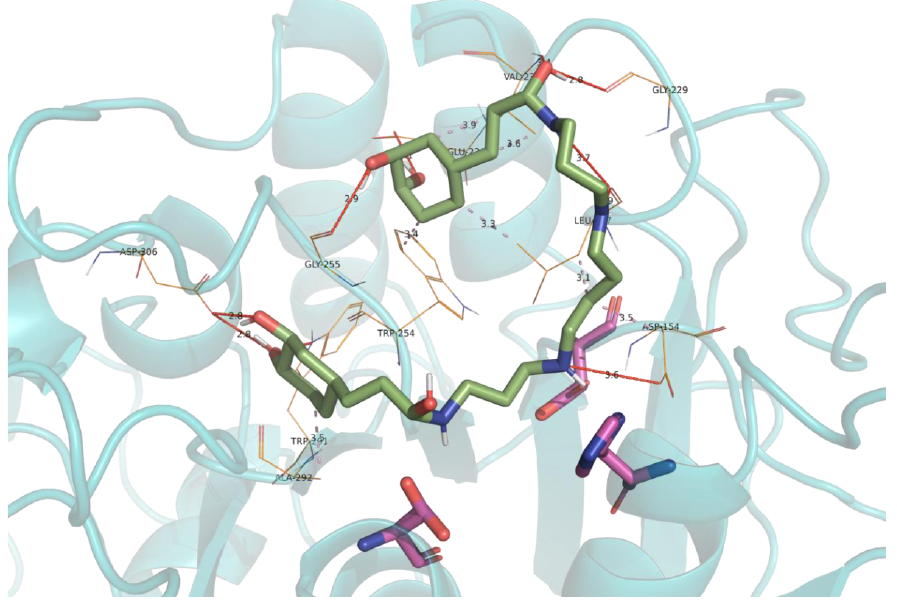
Figure 5. Obtained docking pose for Kukoamine A into the active site of furin. The carbon skeleton of Kukoamine A is depicted in green, while the carbon skeleton of catalytic triad residues is depicted in pink. Main interaction residues are shown in lines represented in orange. Hydrogen interactions are represented by red dashed lines, while hydrophobic interactions are shown by purple dashed lines. The secondary structure of the protein is shown in cartoon representation.